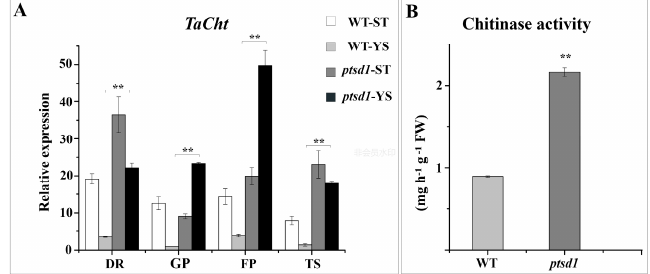
Figure 7. Expression pattern of chitinase gene TaCht and chitinase activity in spikes of WT and ptsd1 . The asterisks represent the significant difference between WT and ptsd1 (**: p ≤ 0.01).